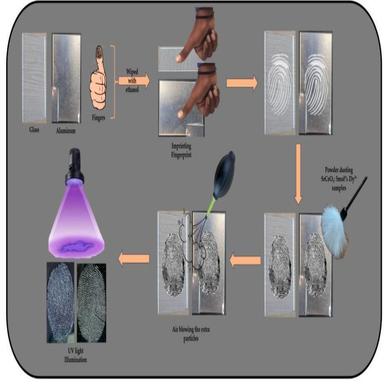
Visualization of latent fingerprint developed using SCD5 under UV illumination.